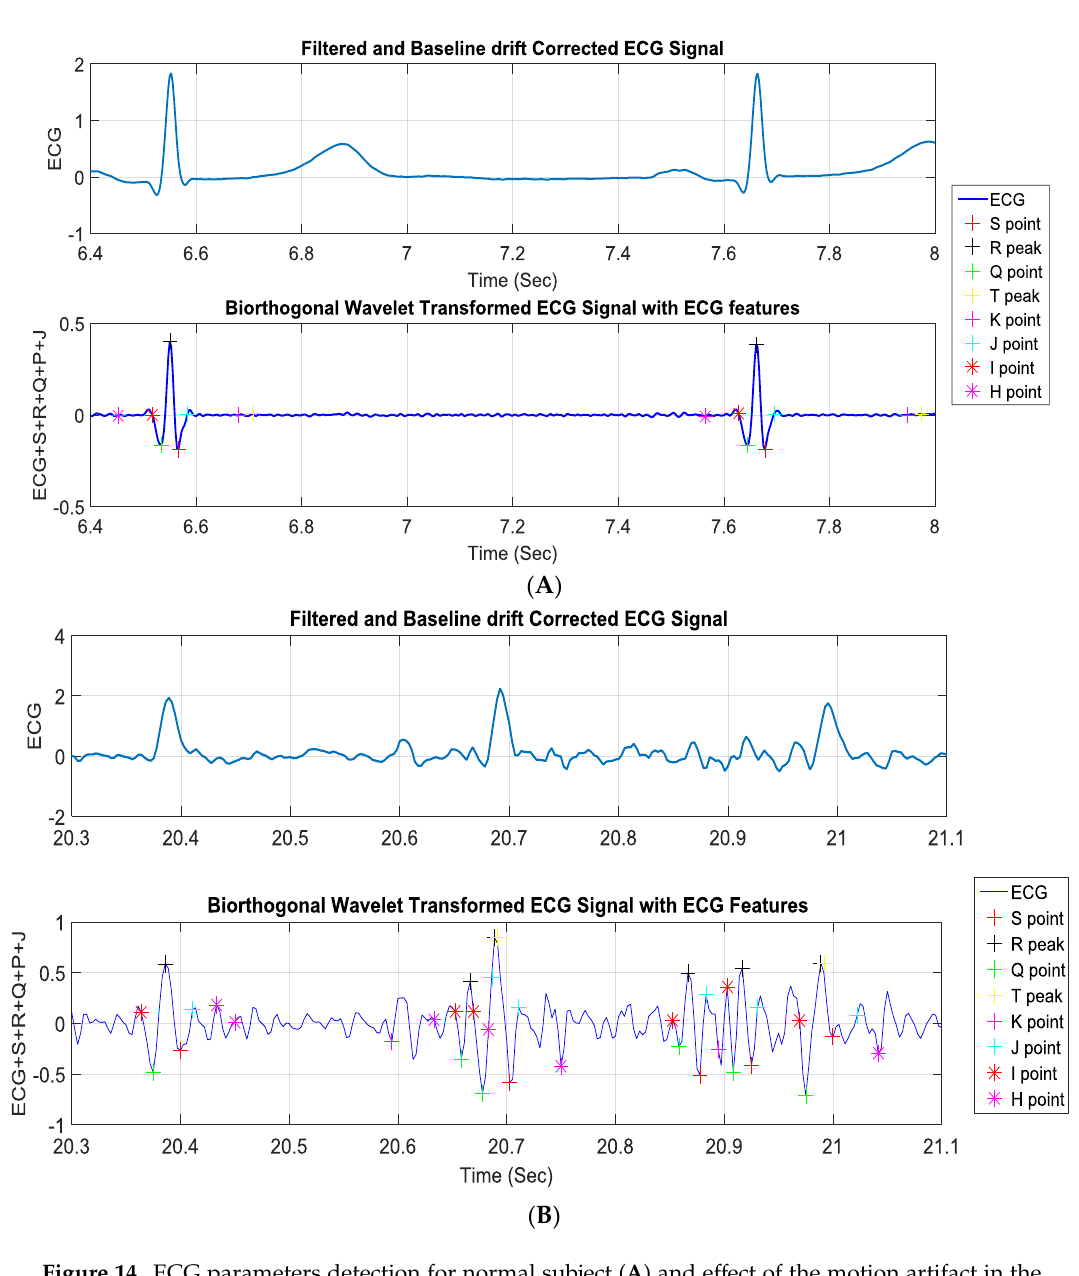
Figure 14. ECG parameters detection for normal subject ( A ) and effect of the motion artifact in the linear classification algorithm ( B ).